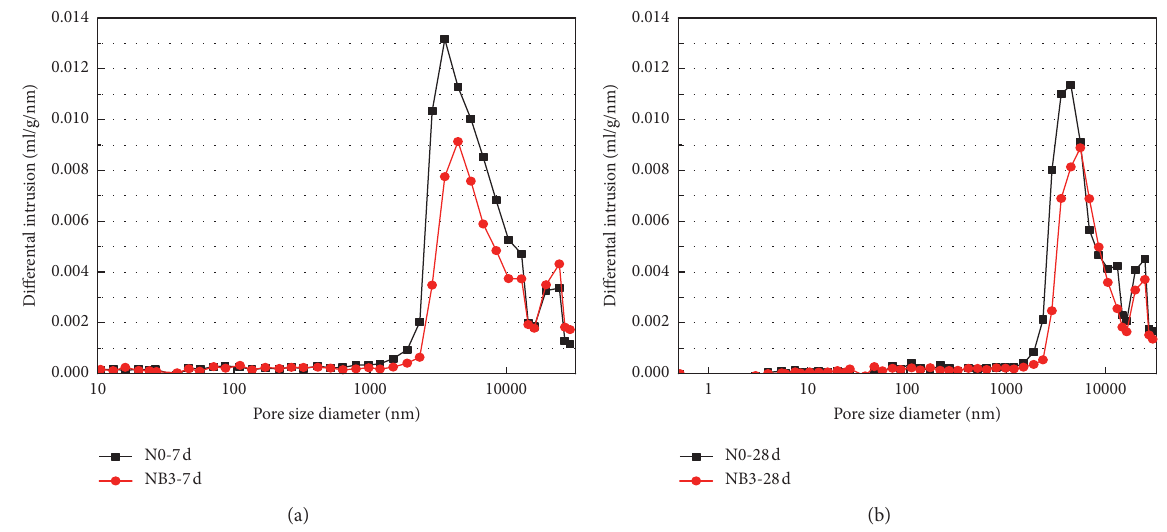
Figure 12: The pore size distribution of samples N0 and NB3 at a curing period of: (a) 3 days and (b) 28